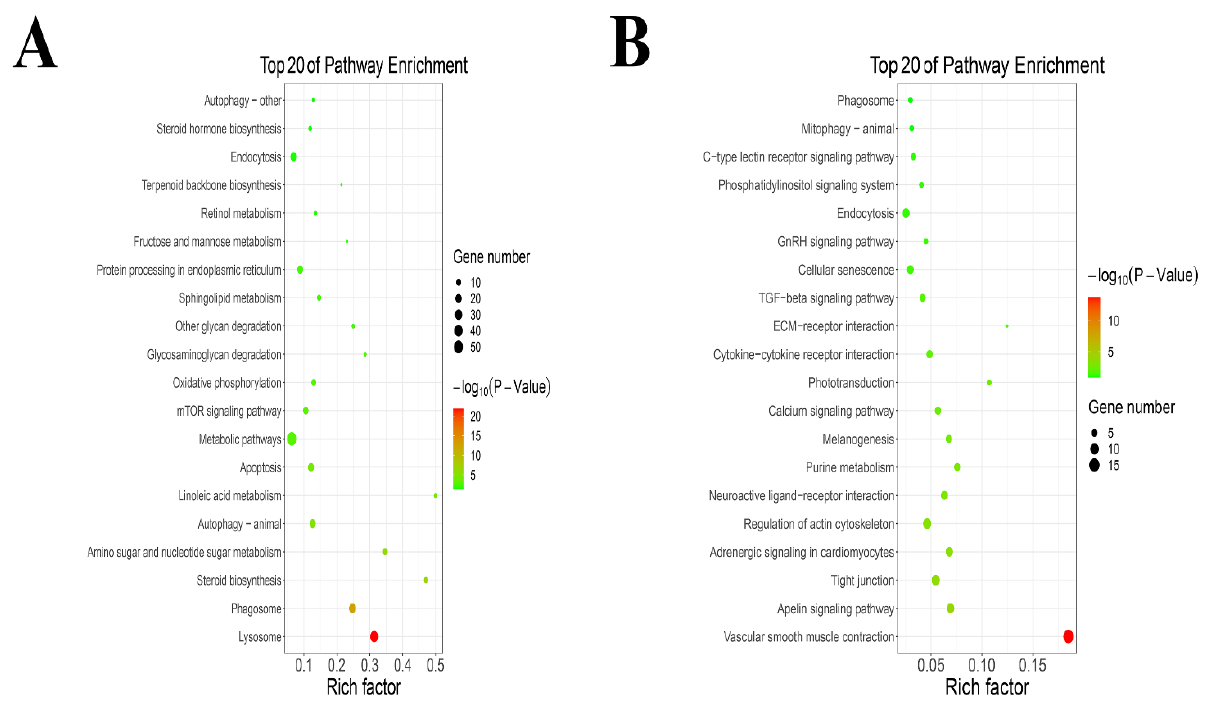
Figure 3. The KEGG pathway enrichment analysis. (A) The KEGG pathway enrichment analysis of up-regulated genes. (B) The KEGG pathway enrichment analysis of down-regulated genes.